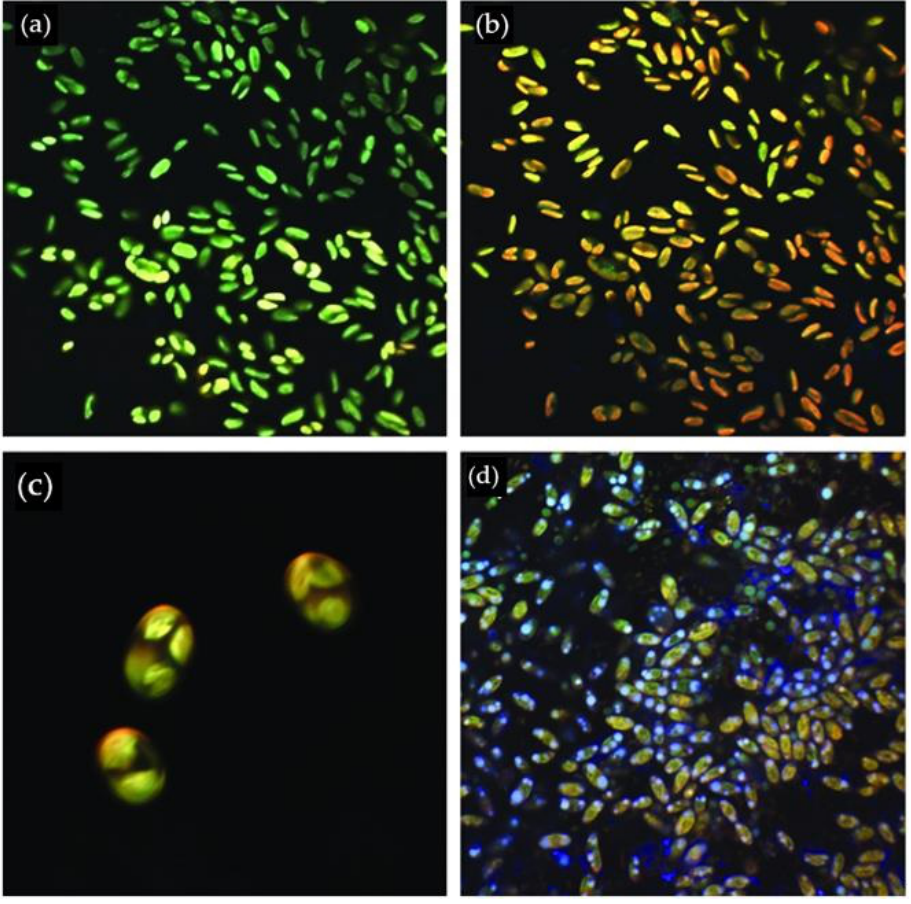
Figure 1. ( a , b ) Confocal images of C. subglobosa chloroplasts. ( c ) 3D reconstruction image of C. subglobosa chloroplasts (scanner zoom, 1.773; calibration value, 0.02 µm/px). ( d ) Confocal image of intracellular lipid droplets (indicated by blue color).